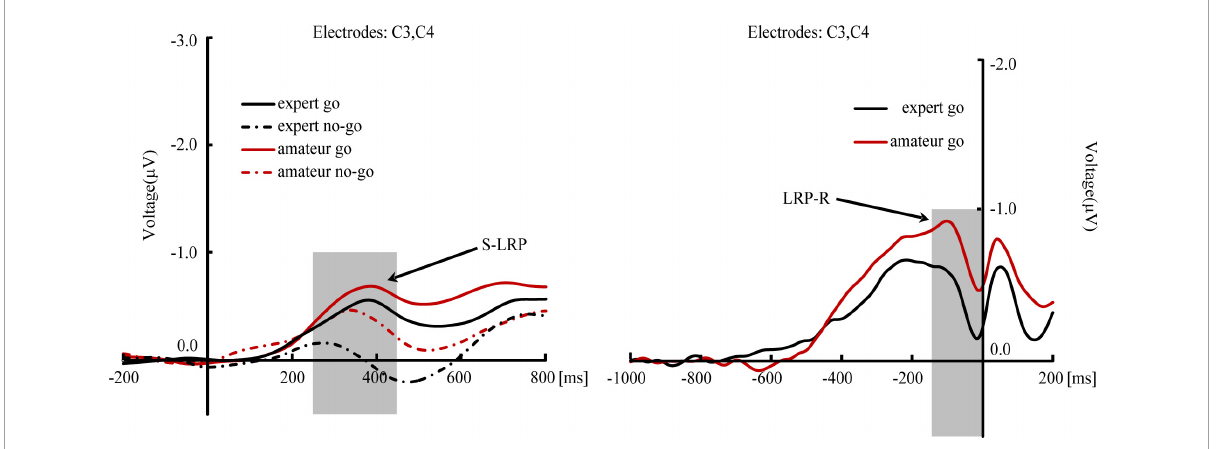
FIGURE3 Event-related potential responses to the go and no-go trials for LOL experts and amateurs. The left figure shows the event-related potential responses on the go and no-go trials that are stimulus-locked. The right figure shows the event-related potential responses to the go trials that are response-locked. The zero on the x-axis indicates the onset of stimulus in the left and the onset of responses in the right. The electrodes selected were C3 and C4. The shadow box indicates the time window of the LRP component. S-LRP indicates stimulus-locked lateralized readiness potential; LRP-R indicates response-locked lateralized readiness potential.